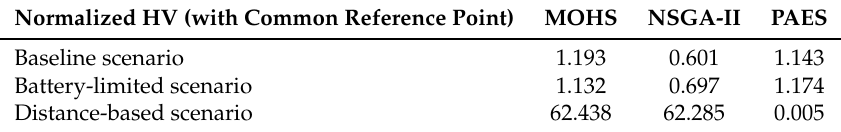
Table 3. Normalized hypervolume (%) with a common reference point per multi-objective approach and real use case